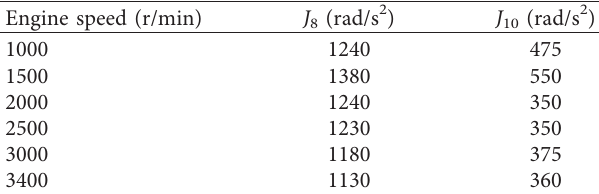
Table 9: The 2 nd order angular acceleration amplitudes under the driving condition for the powertrain matching the